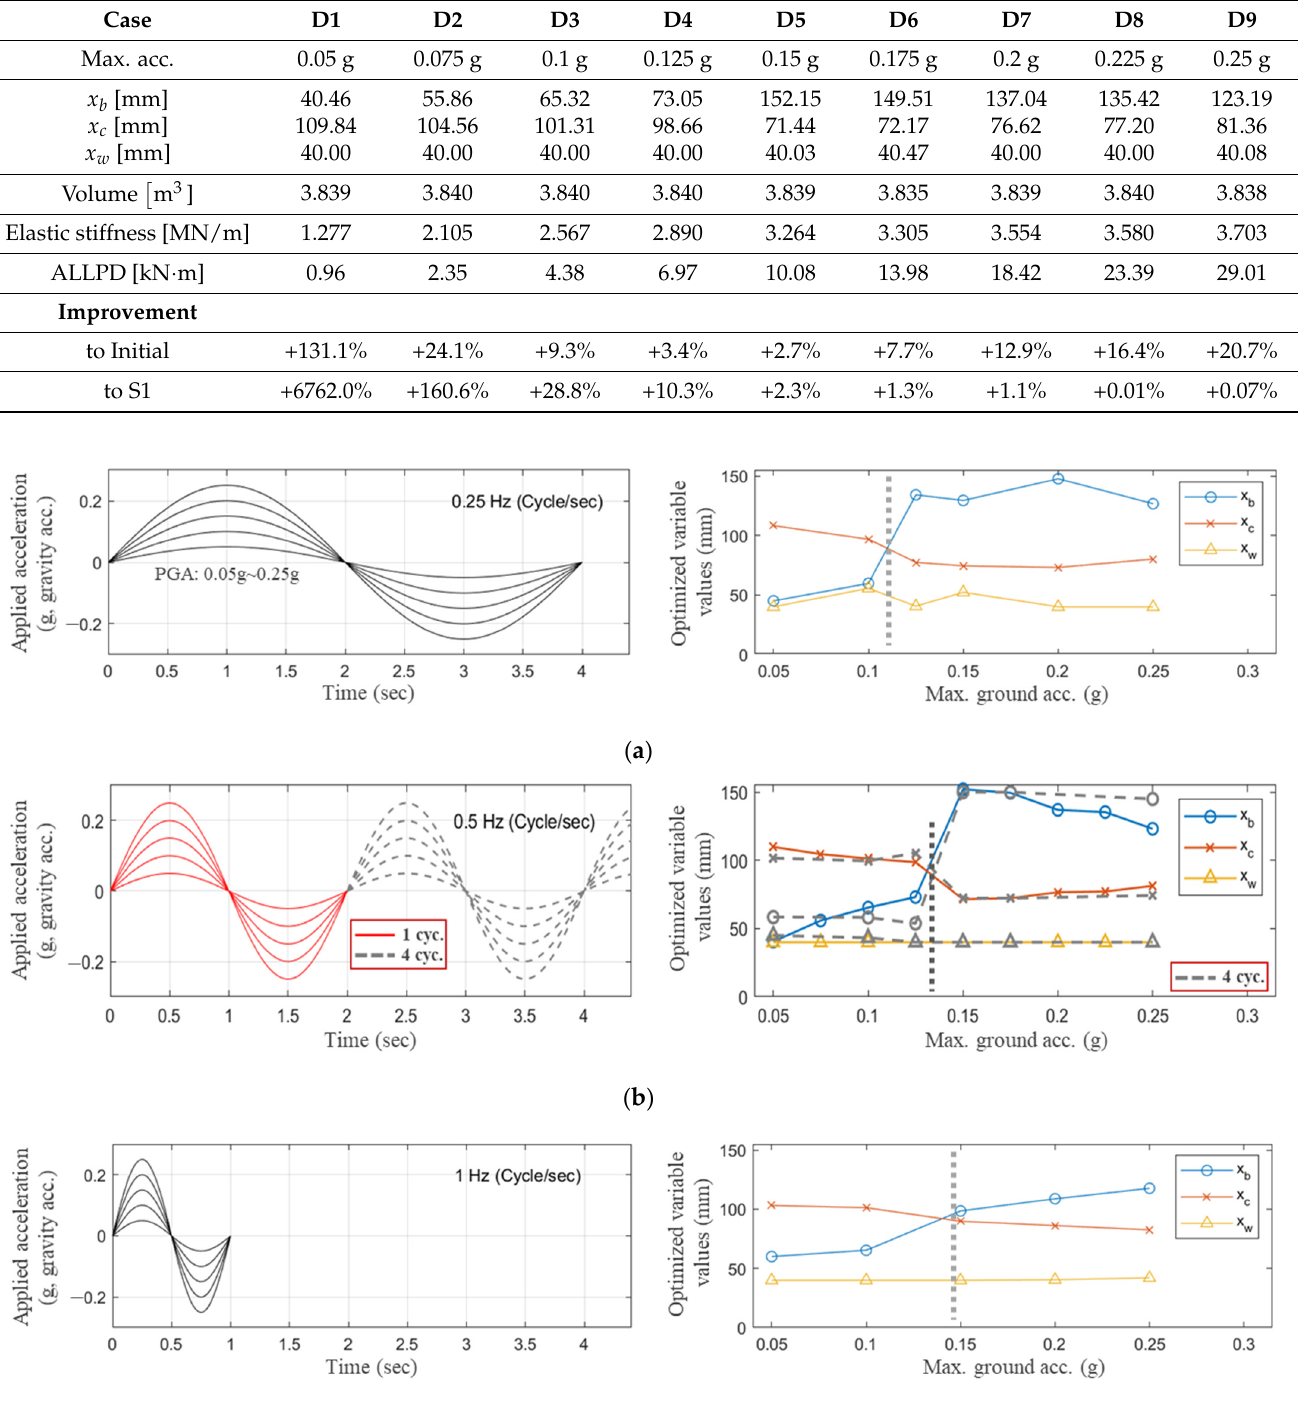
Table 3. Shape variable values, energy dissipation, and improvement of each optimized model with a fixed